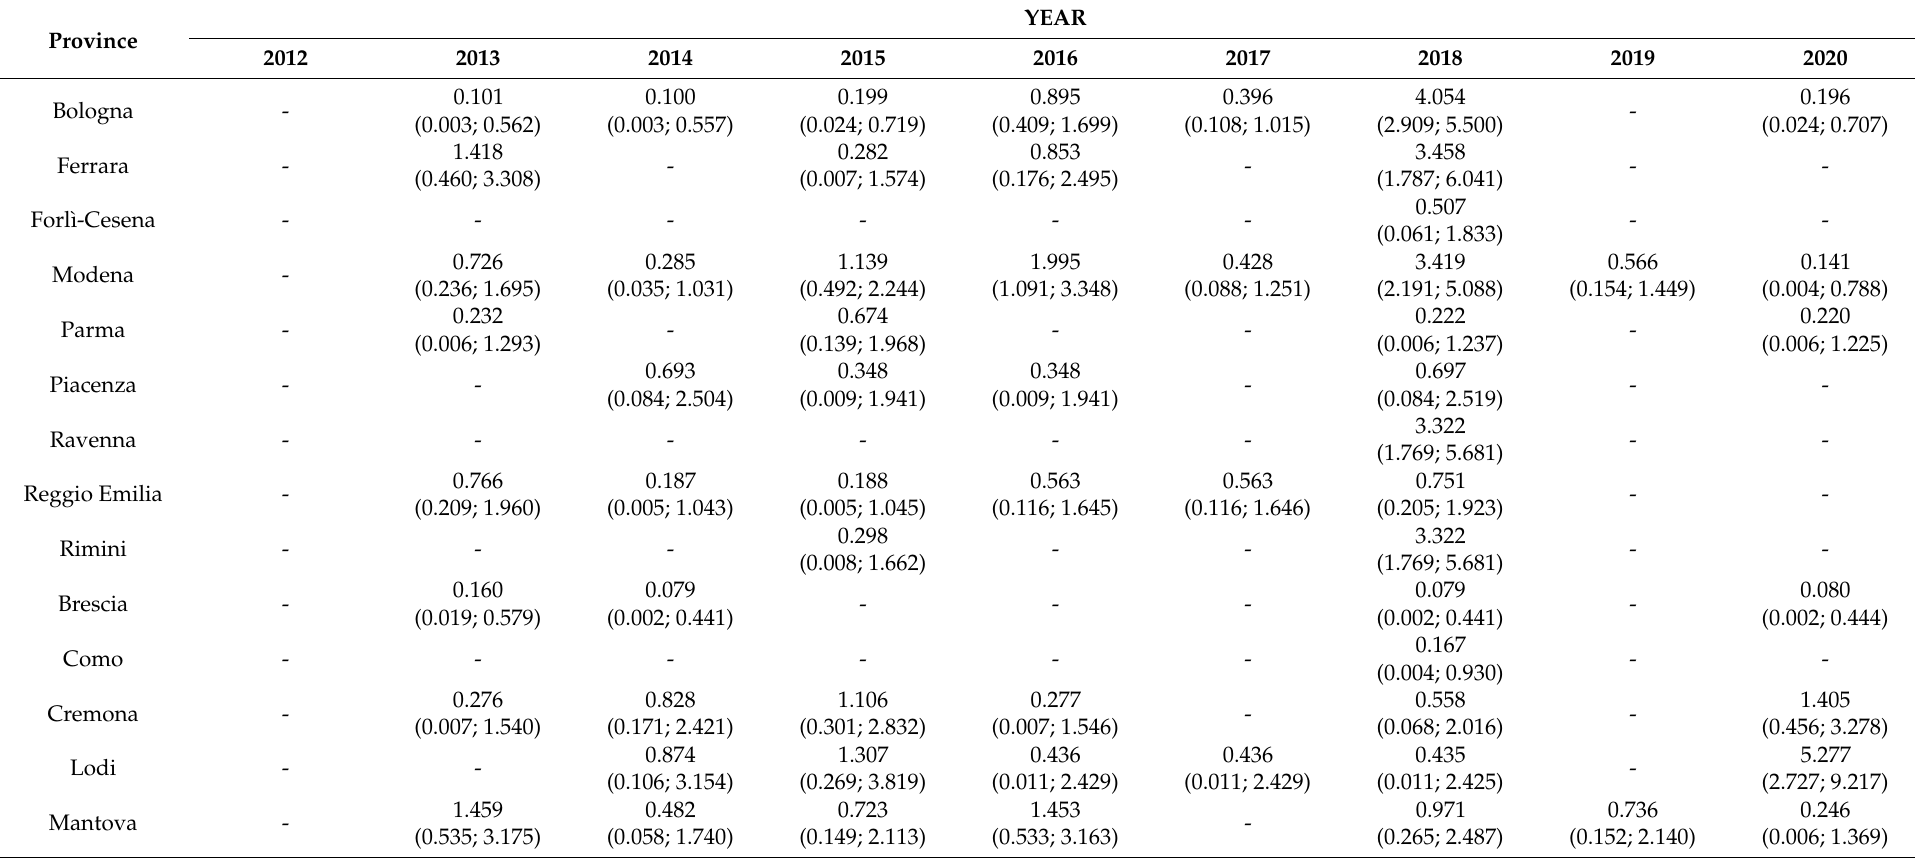
Table A2. Crude Incidence of West Nile Neuro-Invasive Disease (WNND) Cases per Province of Notification and Year, Italy, 2012–2020 ( n = 487 WNND Cases). Pooled Estimates were Calculated on the Total Area Characterized by at Least One WNND Case during the Observation Period; National Estimates were Calculated by Assuming the Italian Population as the Reference